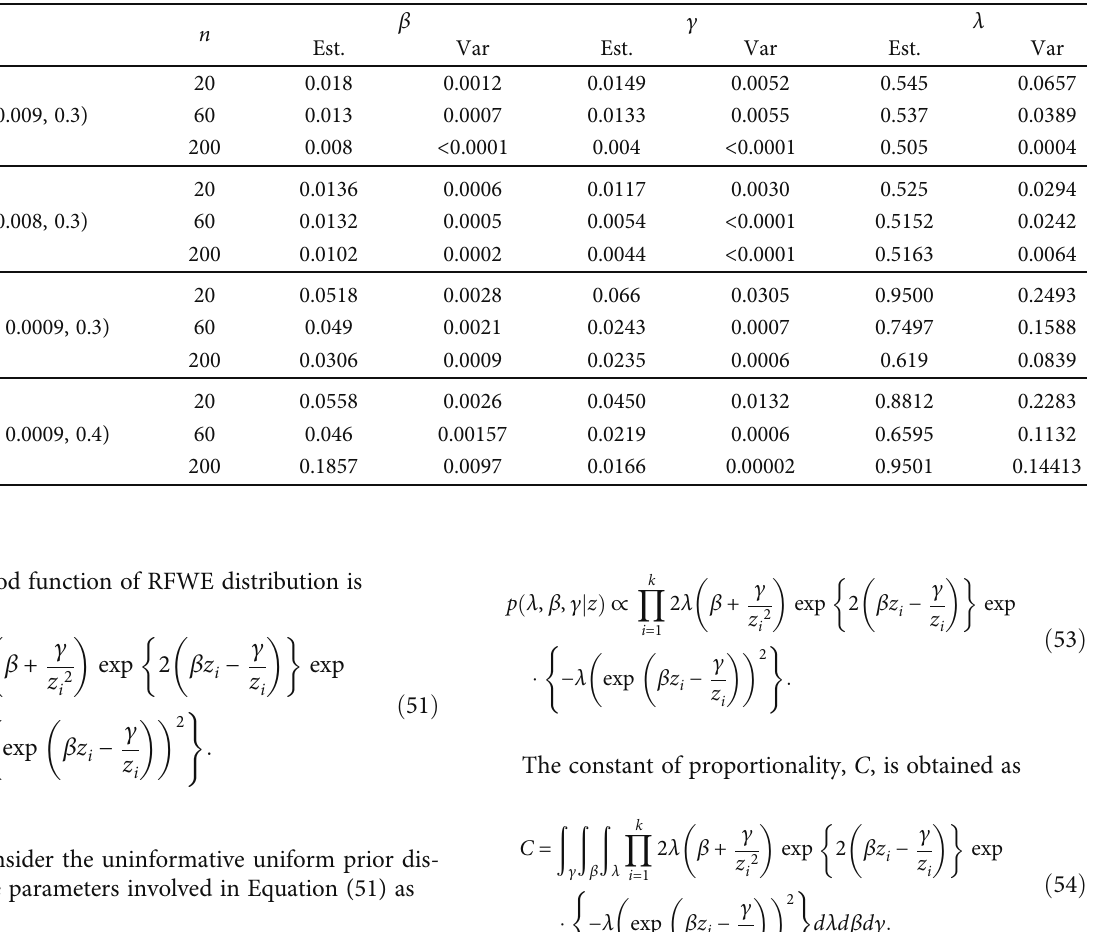
Table 4: True value of parameters with mean (Est.) and variance